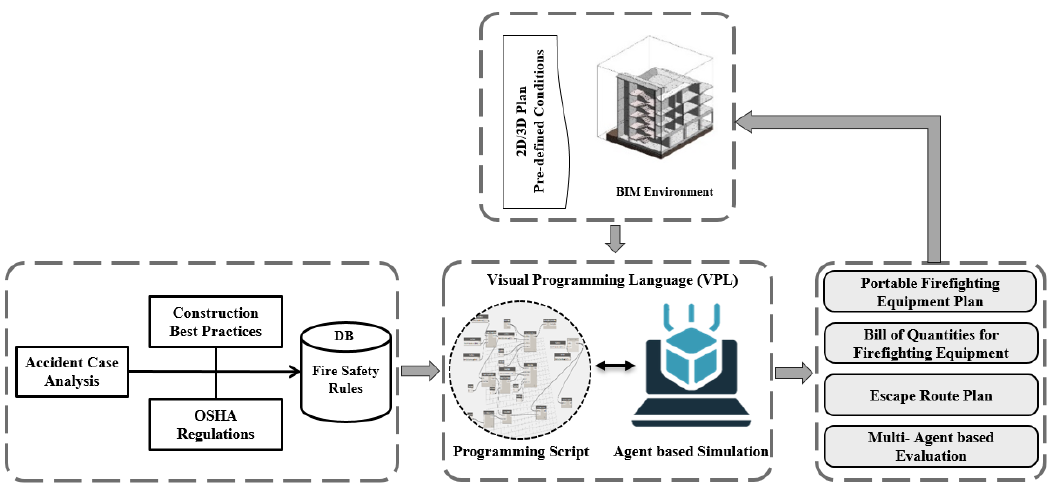
Figure 1. A conceptual framework for fire safety planning in construction